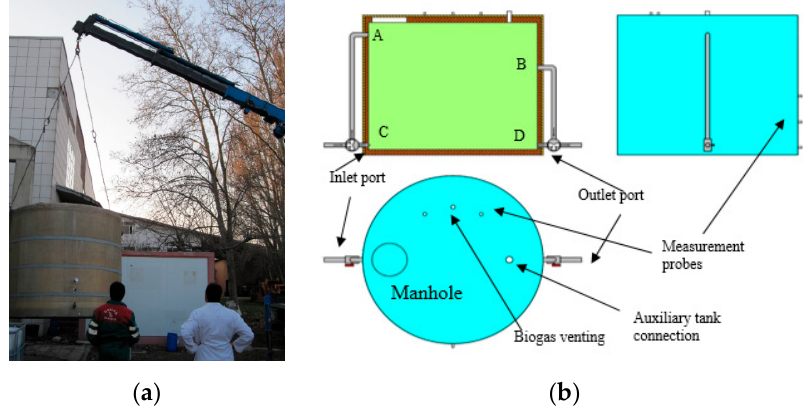
Figure 2. Small decentralized digester for the treatment of food wastes. ( a ) Shipment of the digester once finished to be installed at the testing site; ( b ) Digester configuration and port positioning.